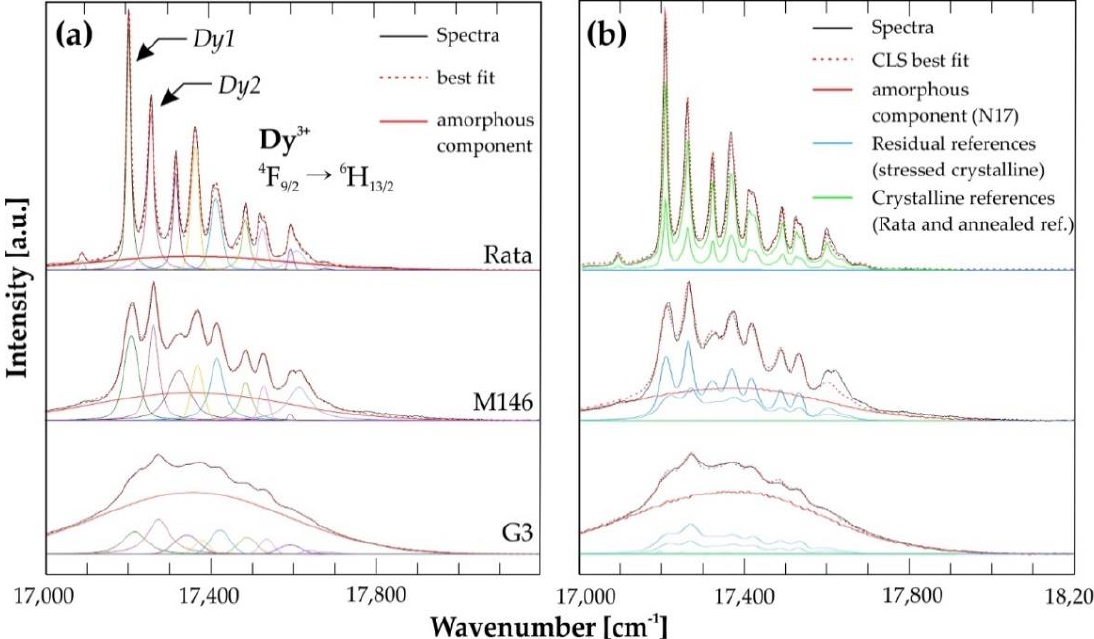
Figure 3. Graphical fitting results that estimate the amorphous fraction f a from the laser-induced PL emission of Dy 3+ ( 4 F 9/2 → 6 H 13/2 ) using two different least-square deconvolution procedures on the example of zircon samples Rata, M146 and G3. ( a ) Individual crystal-field split sub-level bands are modulated with individual Gauss-Lorentz functions with spectral position, FWHM and amplitude treated as free variables that are optimised to fit best with experimental data. The amorphous component is modelled and best described using a Gaussian function with a variable amplitude, but with fixed FWHM of 540 cm −1 and peak position at 17,360 cm −1 (~576 nm). ( b ) Classic least-square (CLS) fitting procedure that takes advantage of multiple references, so-called “loadings”. Those comprise spectra that are considered to represent non-radiation damaged, crystalline samples (e.g., sample Rata or other annealed zircon samples) and a reference from a completely amorphised sample (N17, cf., Figure 1a). Note that band-broadening is accounted for by using several residue spectra of partly-radiation damaged samples with the amorphous component subtracted according to the fitting presented in ( a ).